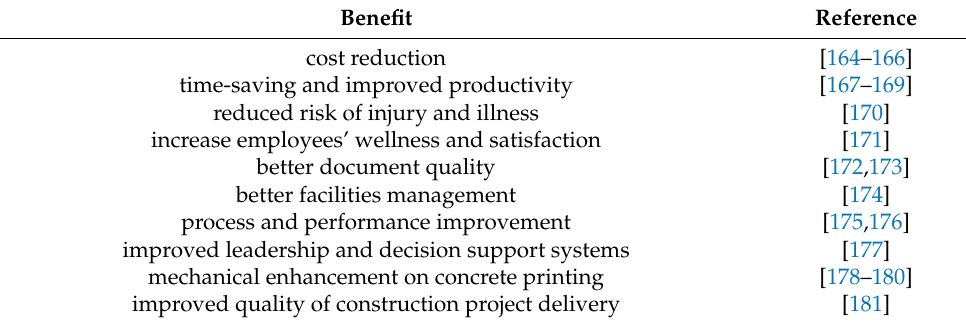
Table 6. Benefits of digital technologies according to construction